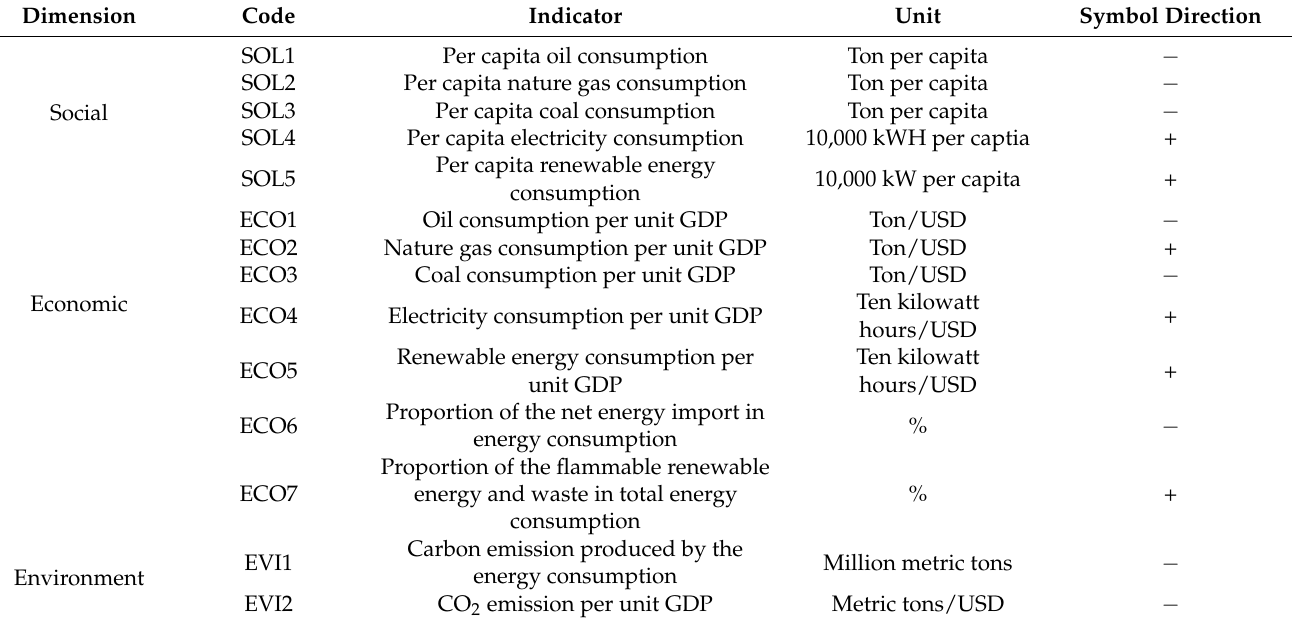
Table 1. The low-carbon energy vulnerability assessment index